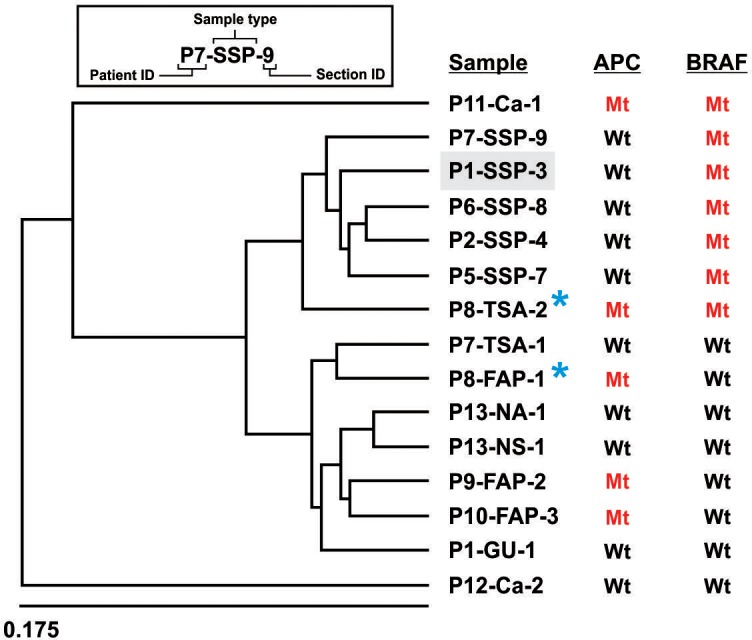
Hierarchical clustering of all CpGs in 450K methyl-array on colon samples.The SSP samples are clustered together based on DNA methylation. The TSA-2 sample that is mutant for BRAF gene also clustered with SSPs.